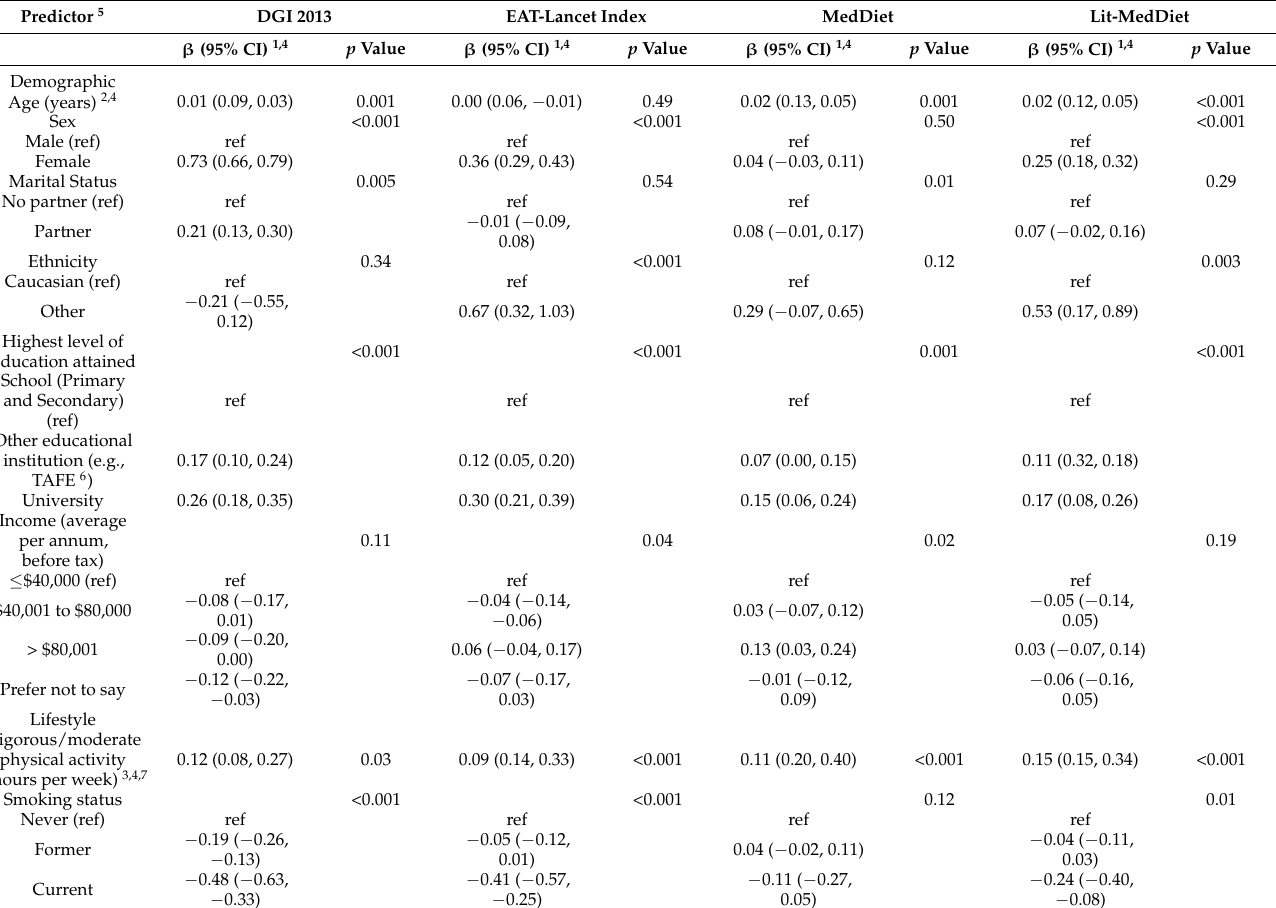
Table 3. Model two beta coefficient estimates of the EAT-Lancet Index, Dietary Guideline Index 2013 (DGI-2013), Mediterranean Diet Index (MedDiet) and the Literature-Based Mediterranean Diet Index (Lit-MedDiet), adjusted for Demographic and Lifestyle